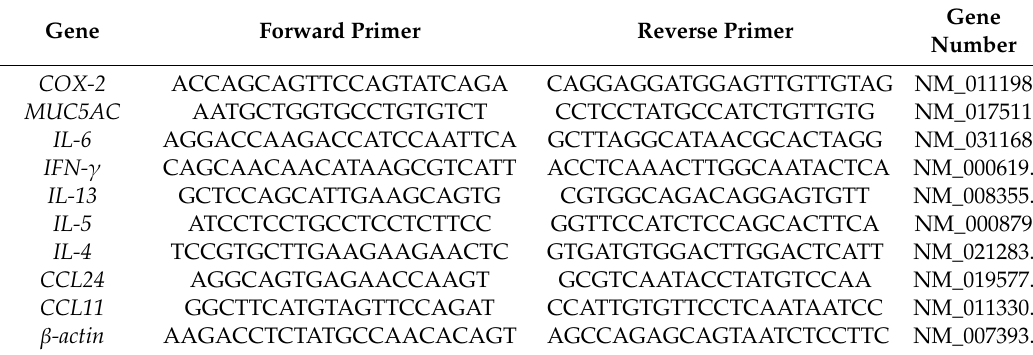
Table 1. Primers used in real-time PCR analysis of cytokine and chemokine mRNA